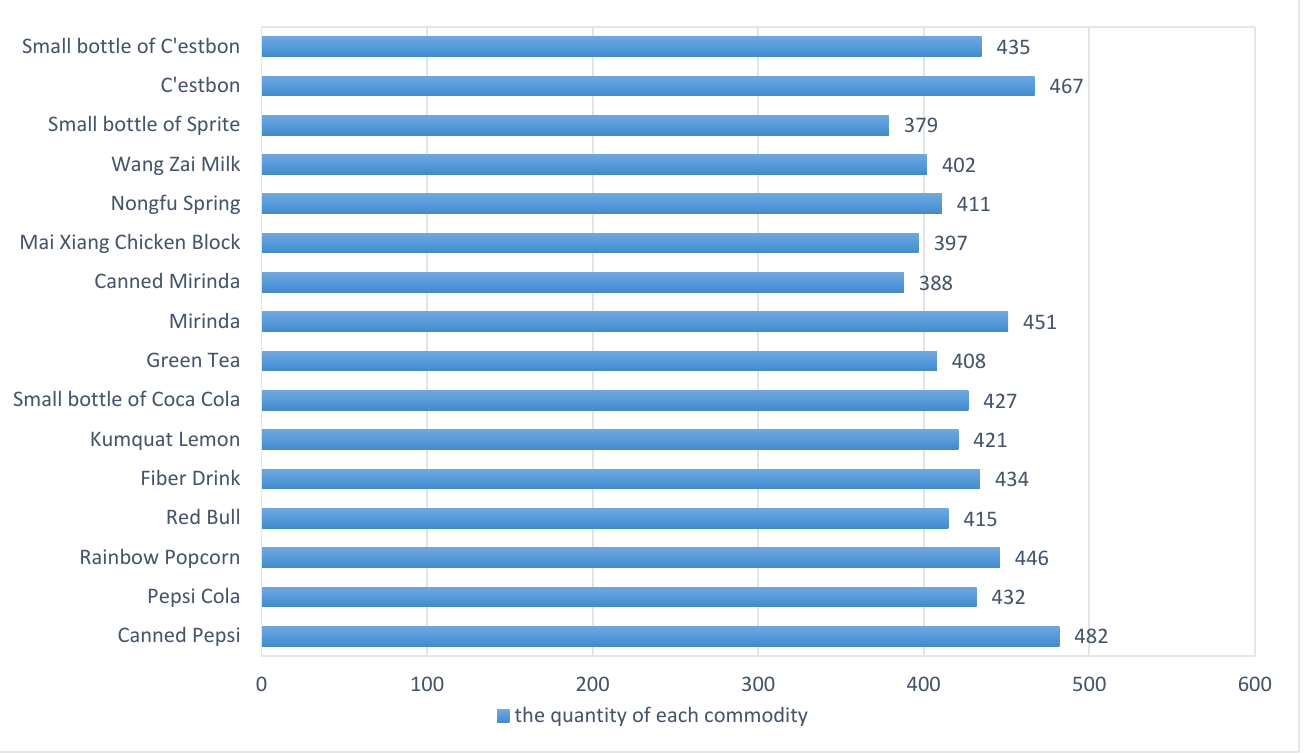
Figure 9. Quantity distribution of each commodity.